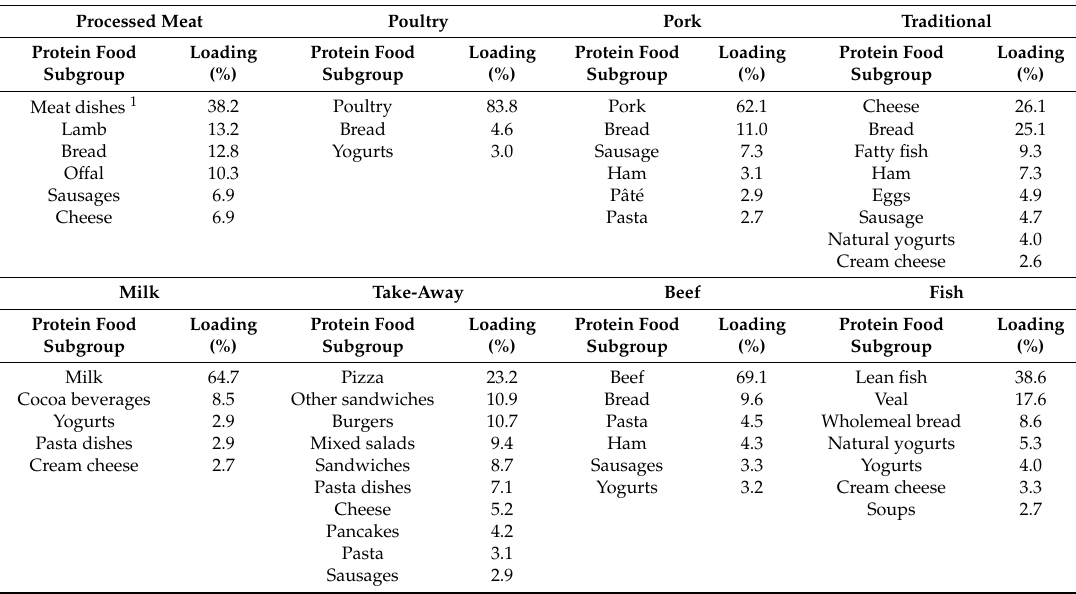
Table 2. Factors identified applying the NMF method to the INCA2 study data ( n = 1678) and loadings of protein food subgroups (%) on the factors.